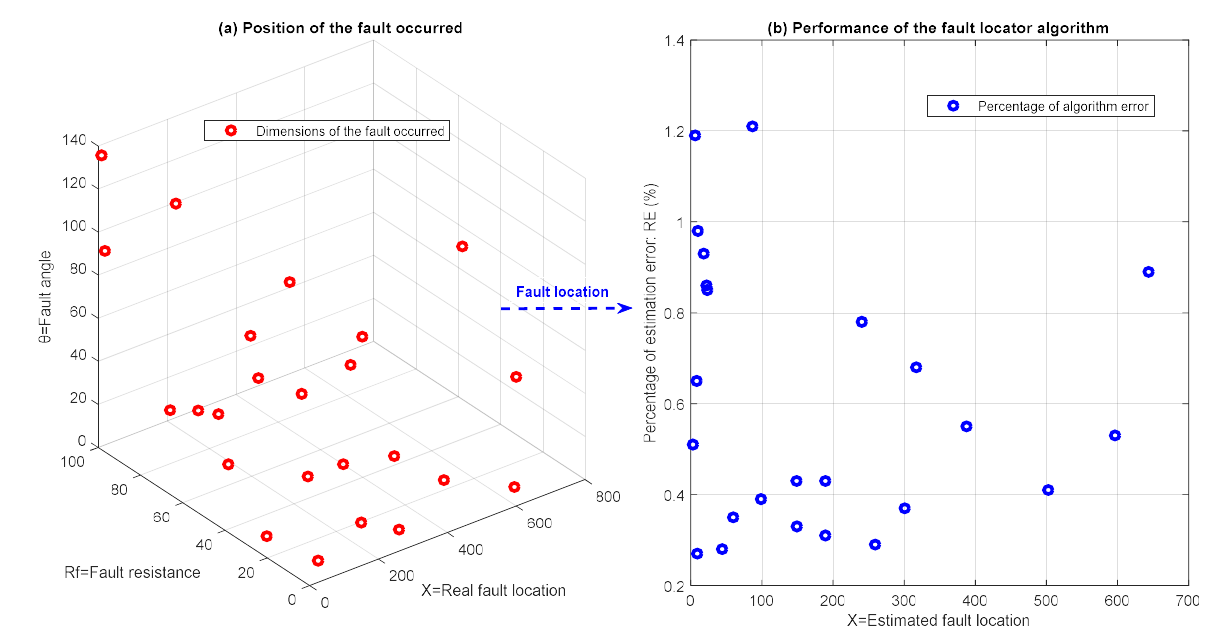
Figure 18. Dimensions of the fault location problem. Table 2. Performance sensitivity analysis of the proposed algorithm for fault parameters.